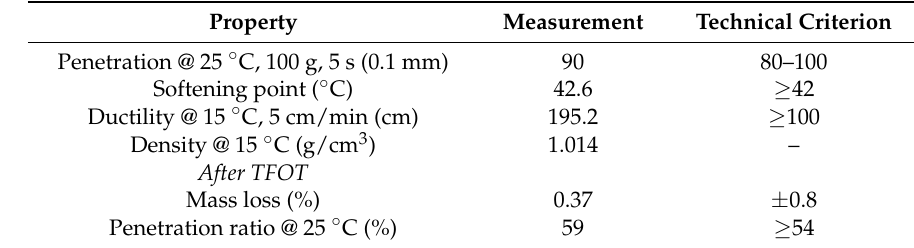
Table 1. Basic physical properties of asphalt AH-90.